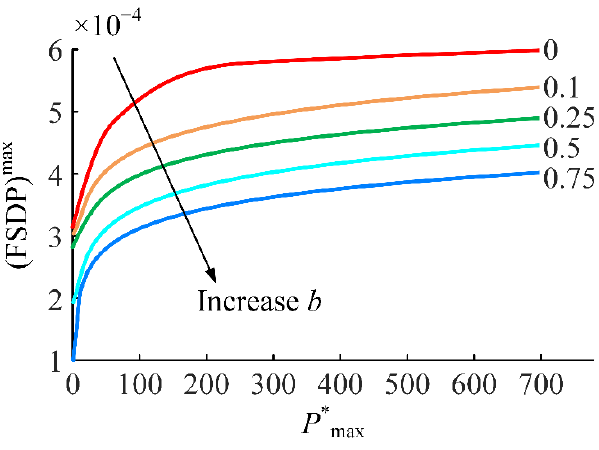
Figure 12. The contour of FSDP/(FSDP)max at the sphere tip when P * max = 700 for b = ( a ) 0.1, ( b ) 0.25, ( c ) 0.5 and ( d ) 0.75.